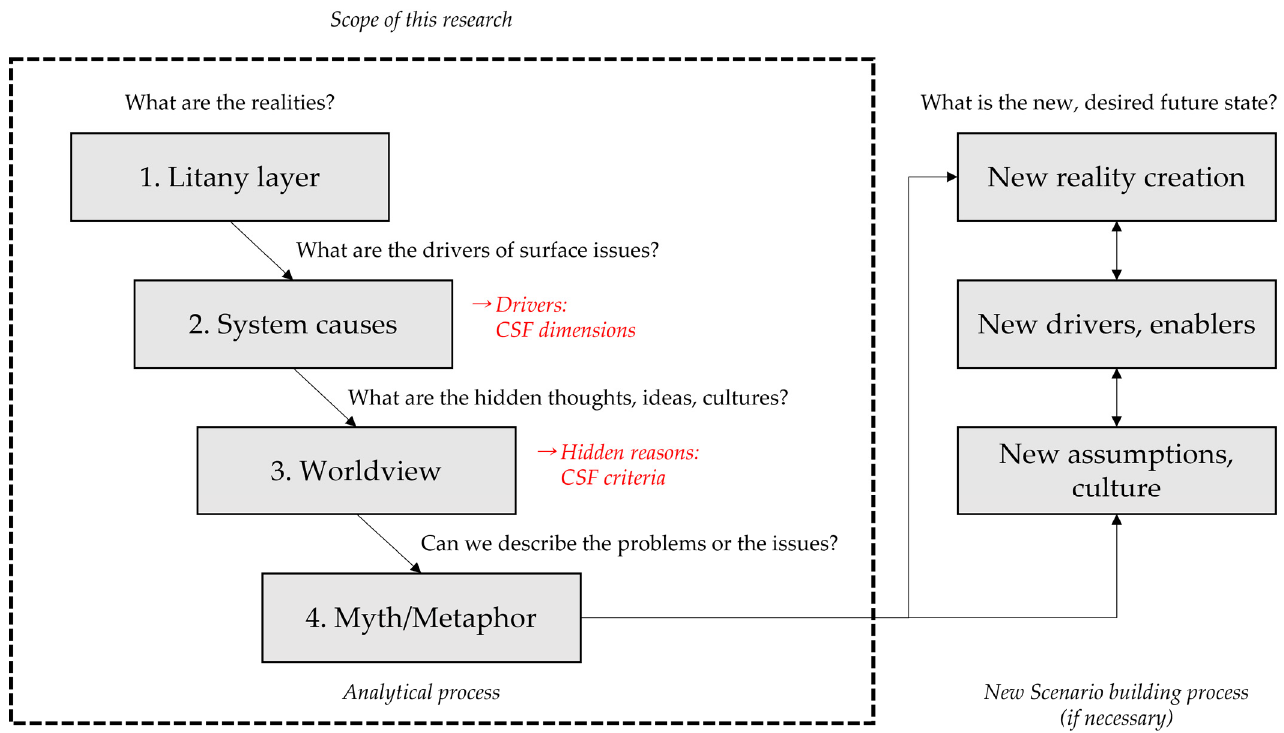
Figure 2. Illustration of CLA process (Source: Author’s elaboration).